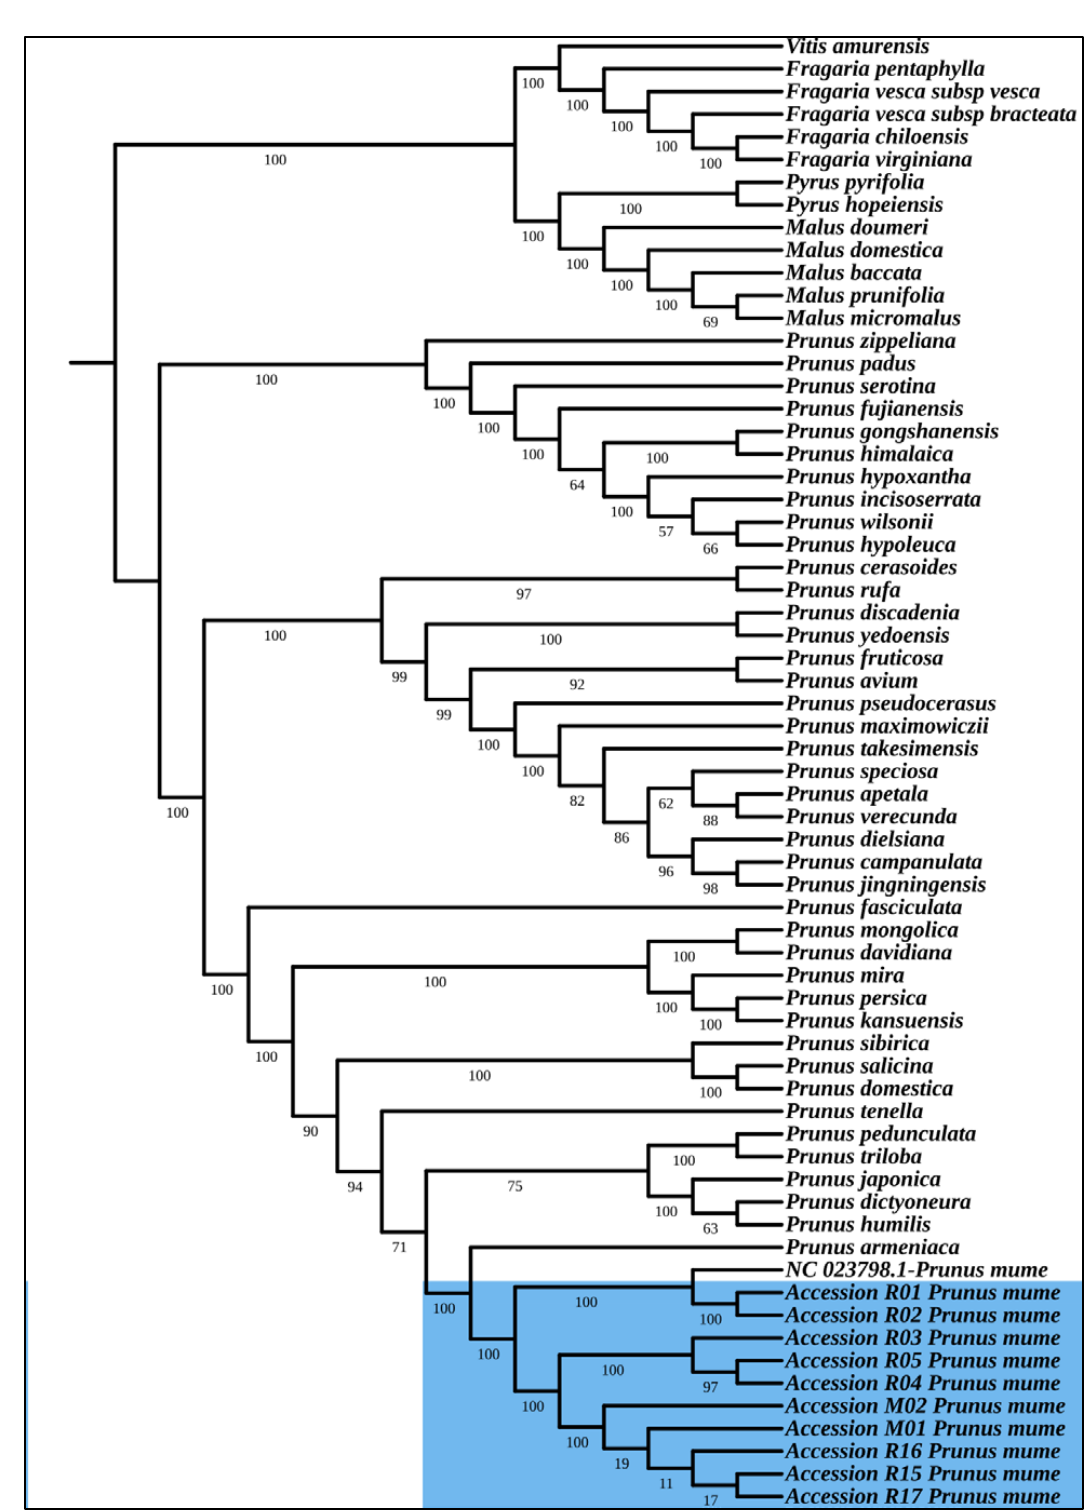
Figure 8. Phylogenetic trees of Prunus mume accessions based on whole cp genomes. Bootstrap support values shown near the nodes or below branches.